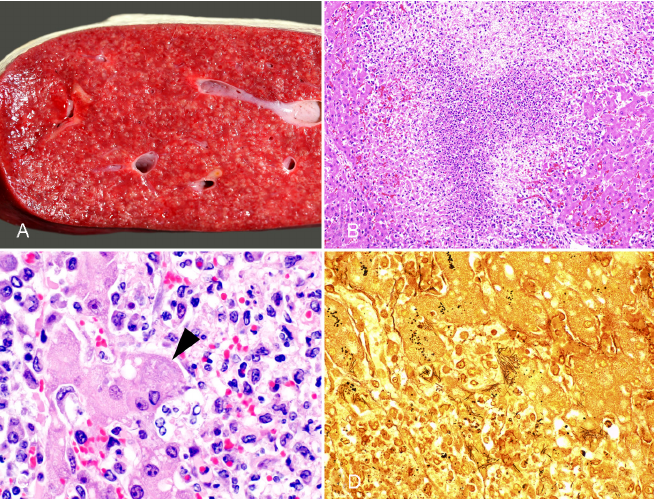
Figure 4. Liver from a foal with Tyzzer disease. ( A ) A cross section of the liver shows multifocal, random white spots distributed throughout the parenchyma. ( B ) Multifocal to coalescing areas of coagulative and lytic necrosis with neutrophilic infiltrate; HE. Reprinted with permission from ref. [77]. Copyright 2017 John Wiley & Sons . ( C ) Focus of necrosis showing faintly stained filamentous basophilic bacilli mostly in the cytoplasm of hepatocytes (arrowhead); HE. ( D ) Filamentous bacilli in the cytoplasm of several hepatocytes. Steiner stain.